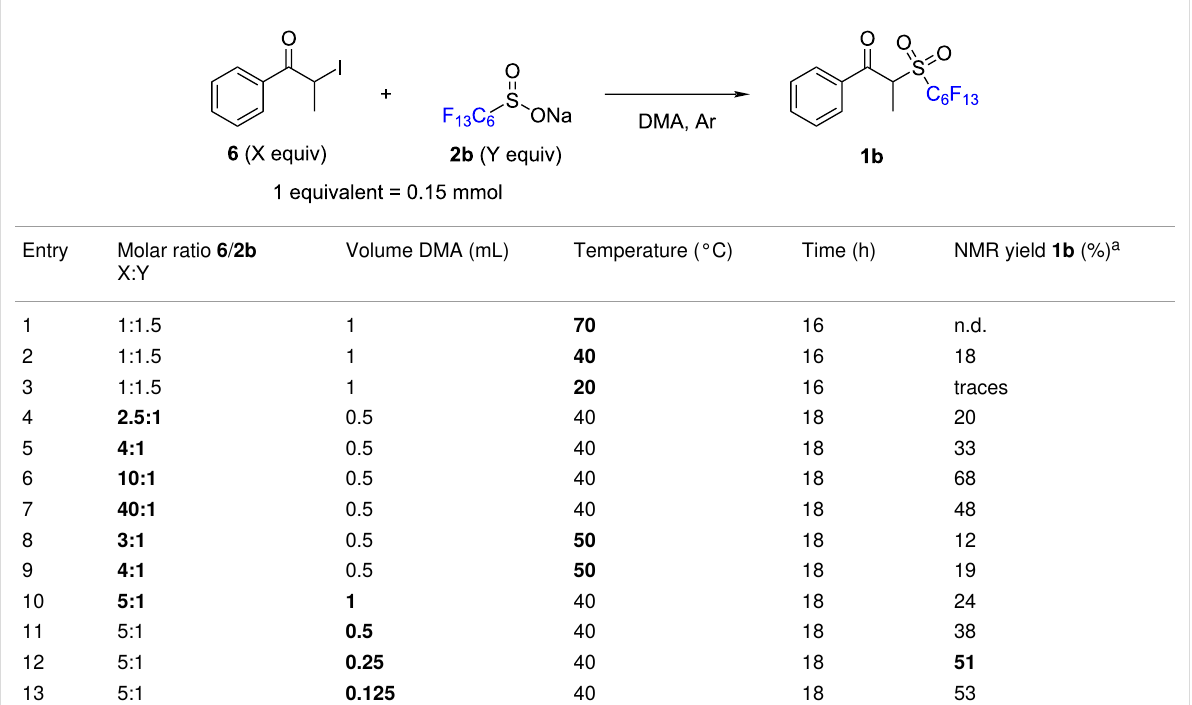
Table 1: Optimization for the nucleophilic substitution between α -iodopropiophenone ( 6 ) and sodium perfluorohexylsulfinate ( 2b